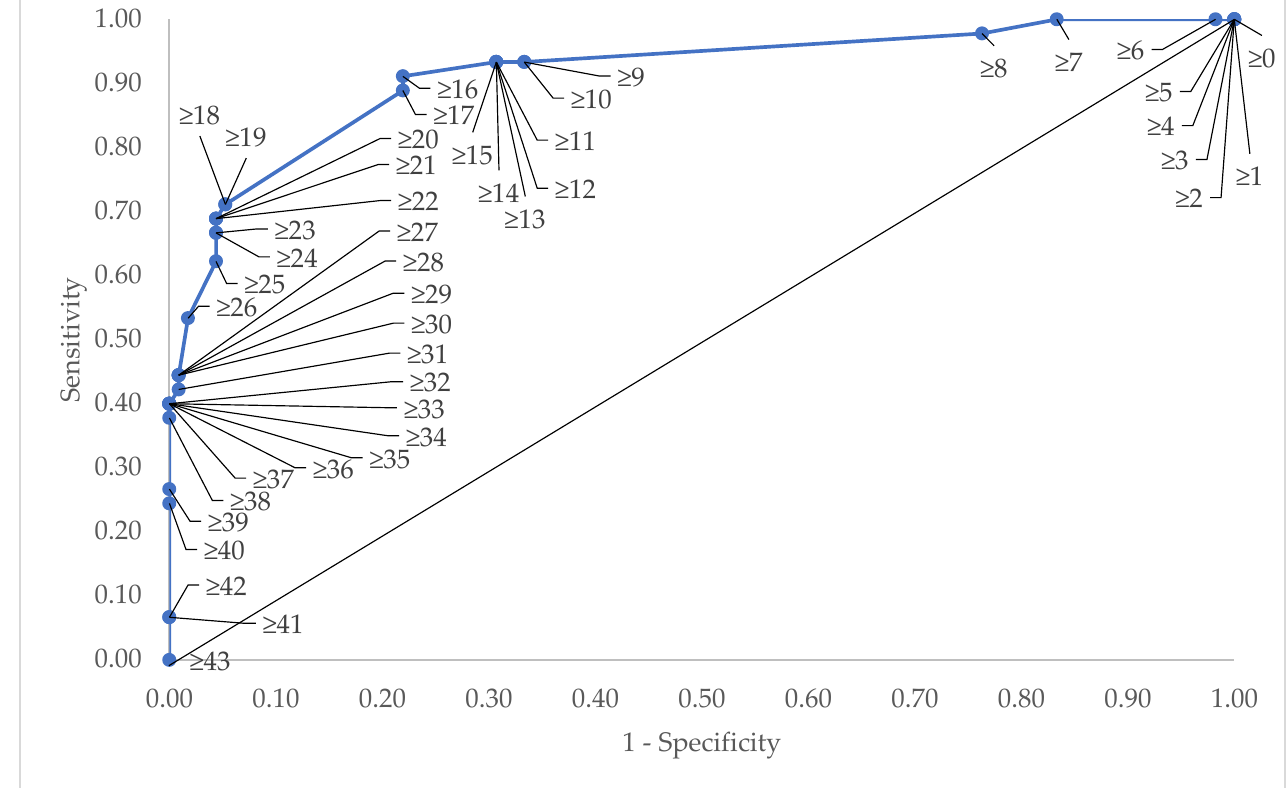
Figure 1. The sensitivity–specificity curve to determine the cut-off point for TBRSS. Eight experts (80.0%) responded to the content validation study, with a median (IQR) duration of experience of sixteen (14) years among them. The range of F-CVI values for all variables was between 0.88 and 1.00. The S-CVI/Ave value was 0.83 (Table 4a). All partic- ipants recruited responded to the face validation study. They included all levels of staff working in the health clinics in the Bachok District. The mean (SD) for the duration of experience working in the health clinics among the participants was 12.8 (6.58) years. The total number of participants for the face validation study was 20 (100.0%). Most partici- pants gave higher scores for the four elements tested in the face validation study (Table 4b). Three participants gave a lower score for the size of the font used in the TBRSS. They preferred the size to be larger. Overall, the total FVI values for all elements were between 0.85 and 1.00.